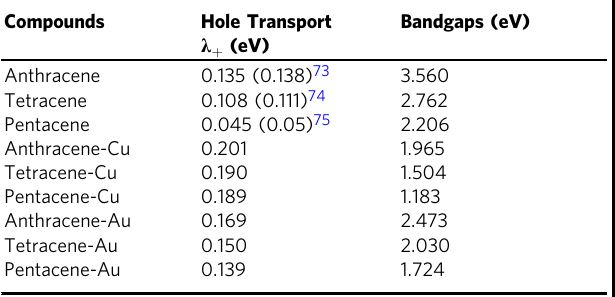
Table 1 Hole transport reorganization energies ( λ + ) and bandgaps of selected polyacenes and their Au(I) and Cu(I) derivatives.